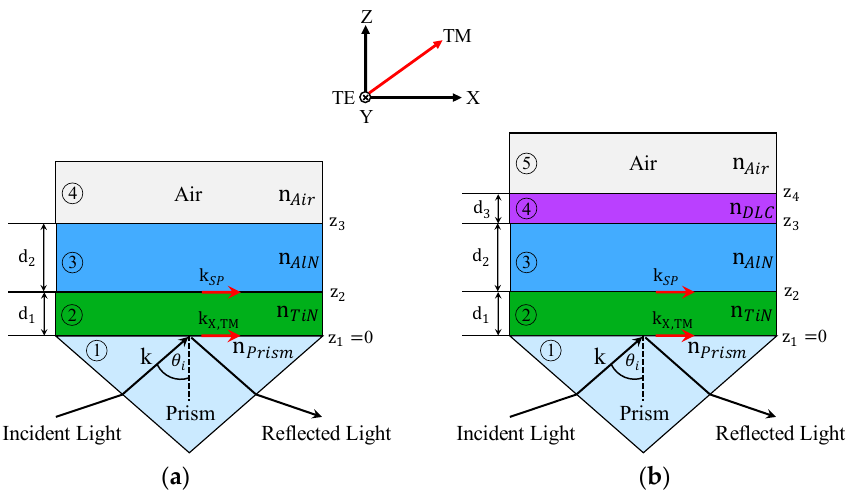
Figure 1. The schematic diagram shows the CPWR structures without a thin DLC film ( a ) and with a thin DLC film to be analyzed ( b ).